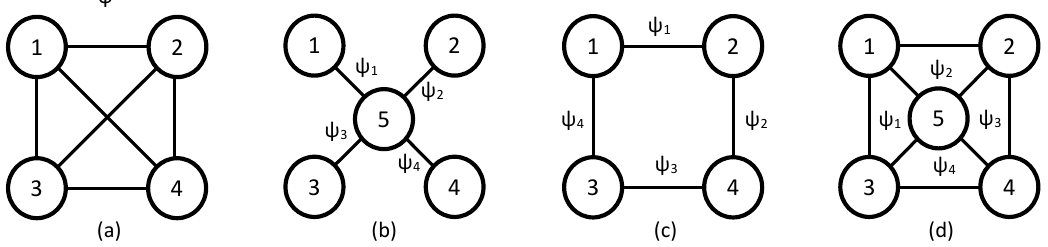
Figure A1. Examples of graph representation of heat integration opportunities between system stream subsets: ( a ) no heat exchange restrictions; ( b ) with heat exchange restrictions and total site stream subset; ( c ) with partial restrictions; ( d ) with partial restrictions and with total site stream subset